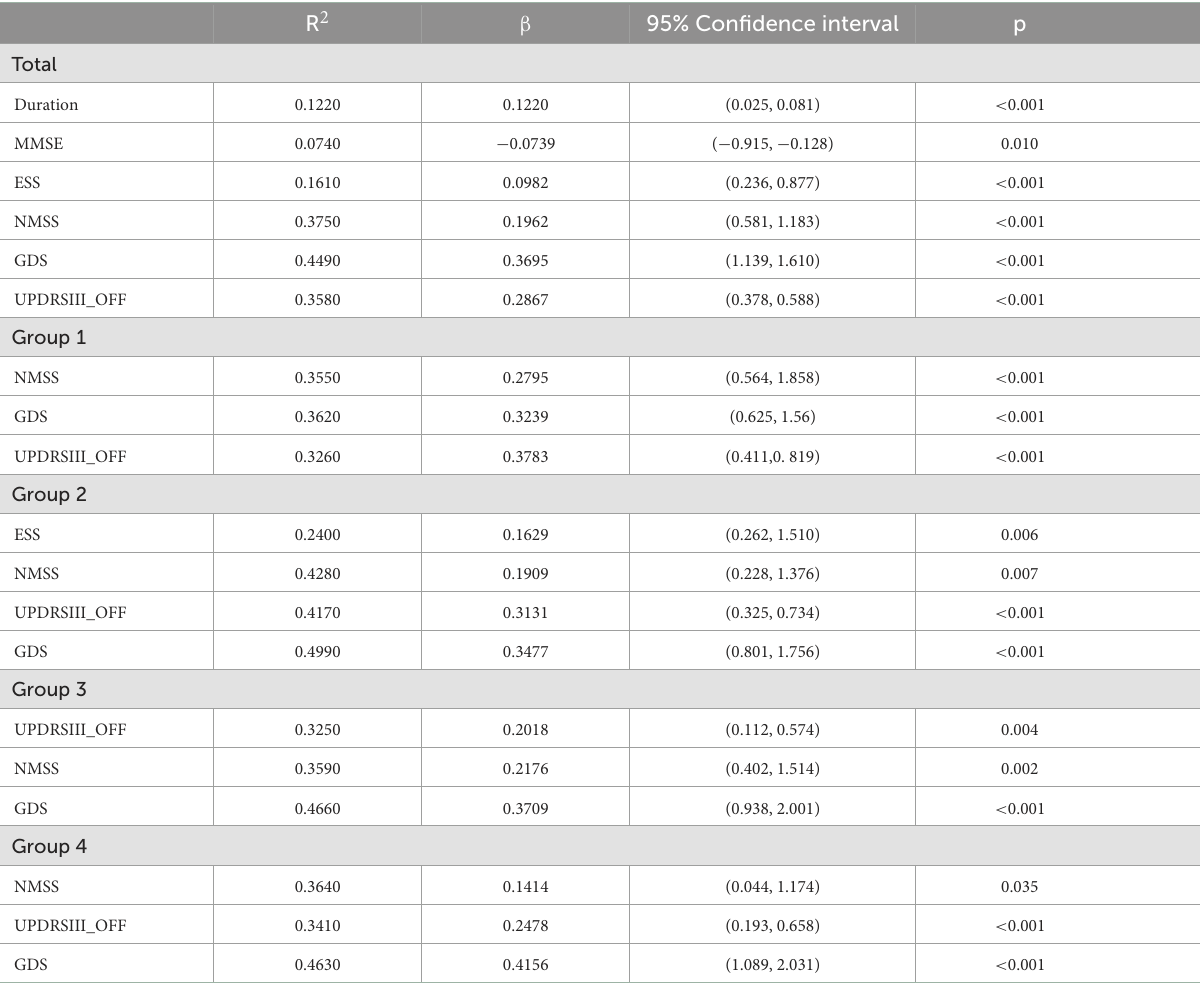
TABLE 2 Multiple stepwise analysis of determinants in four seasonal